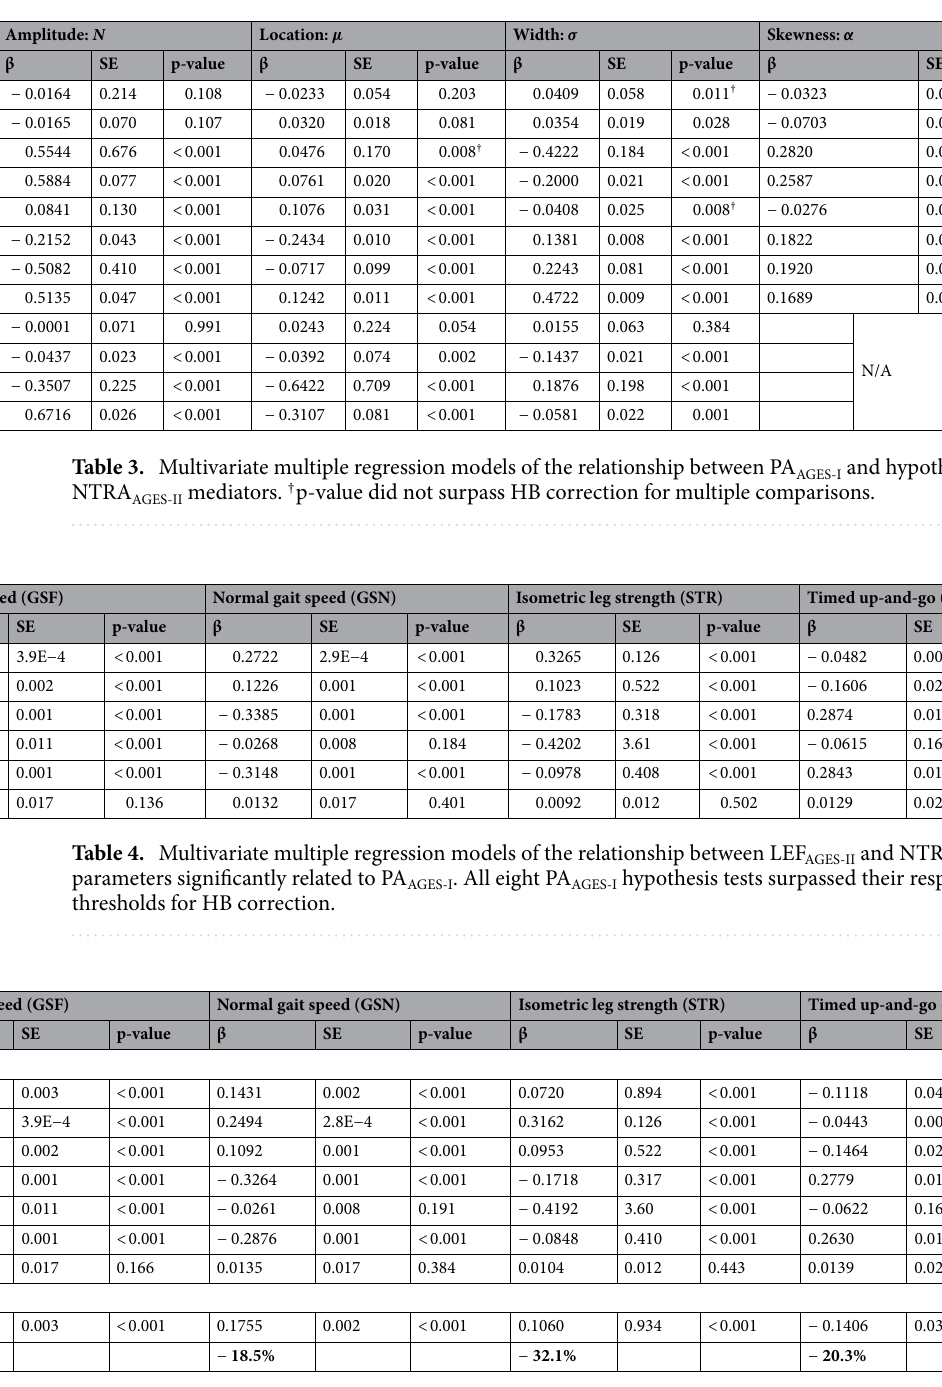
Table 5. Prior PA AGES-I → LEF AGES-II regression models with N m and µ m added as theorized mediators. All twelve hypothesis tests surpassed their respective thresholds for HB